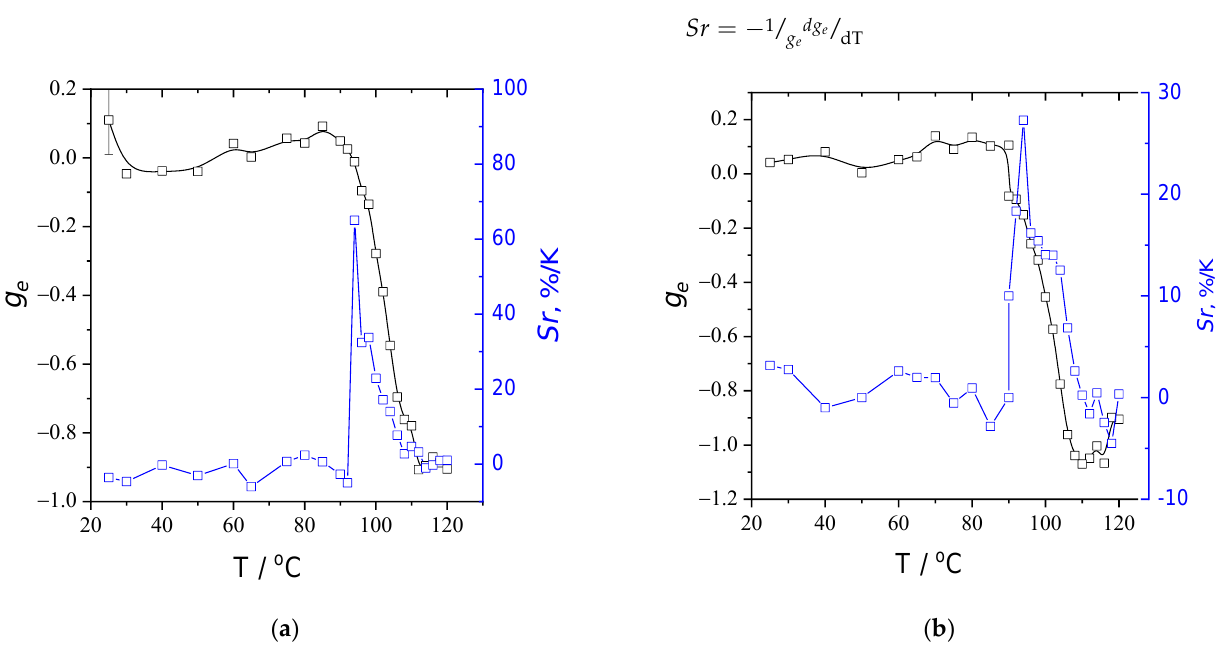
Figure 8. Temperature dependencies of the dissymmetry factor at 592 nm and sensitivity Sr recorded during heating ( a ) and cooling ( b ). The rate of the temperature changes is 1 °C/min. It is noteworthy that Sr reaches ca. 65% when the mixture film is heated. This is an extremely high value, which is several times higher than the highest sensitivity values for classic luminescent thermometry materials obtained to date (i.e., 31%/K at 4 K [22] and 12%/K at 125 K [23]), and an order of magnitude higher than that of thermometers